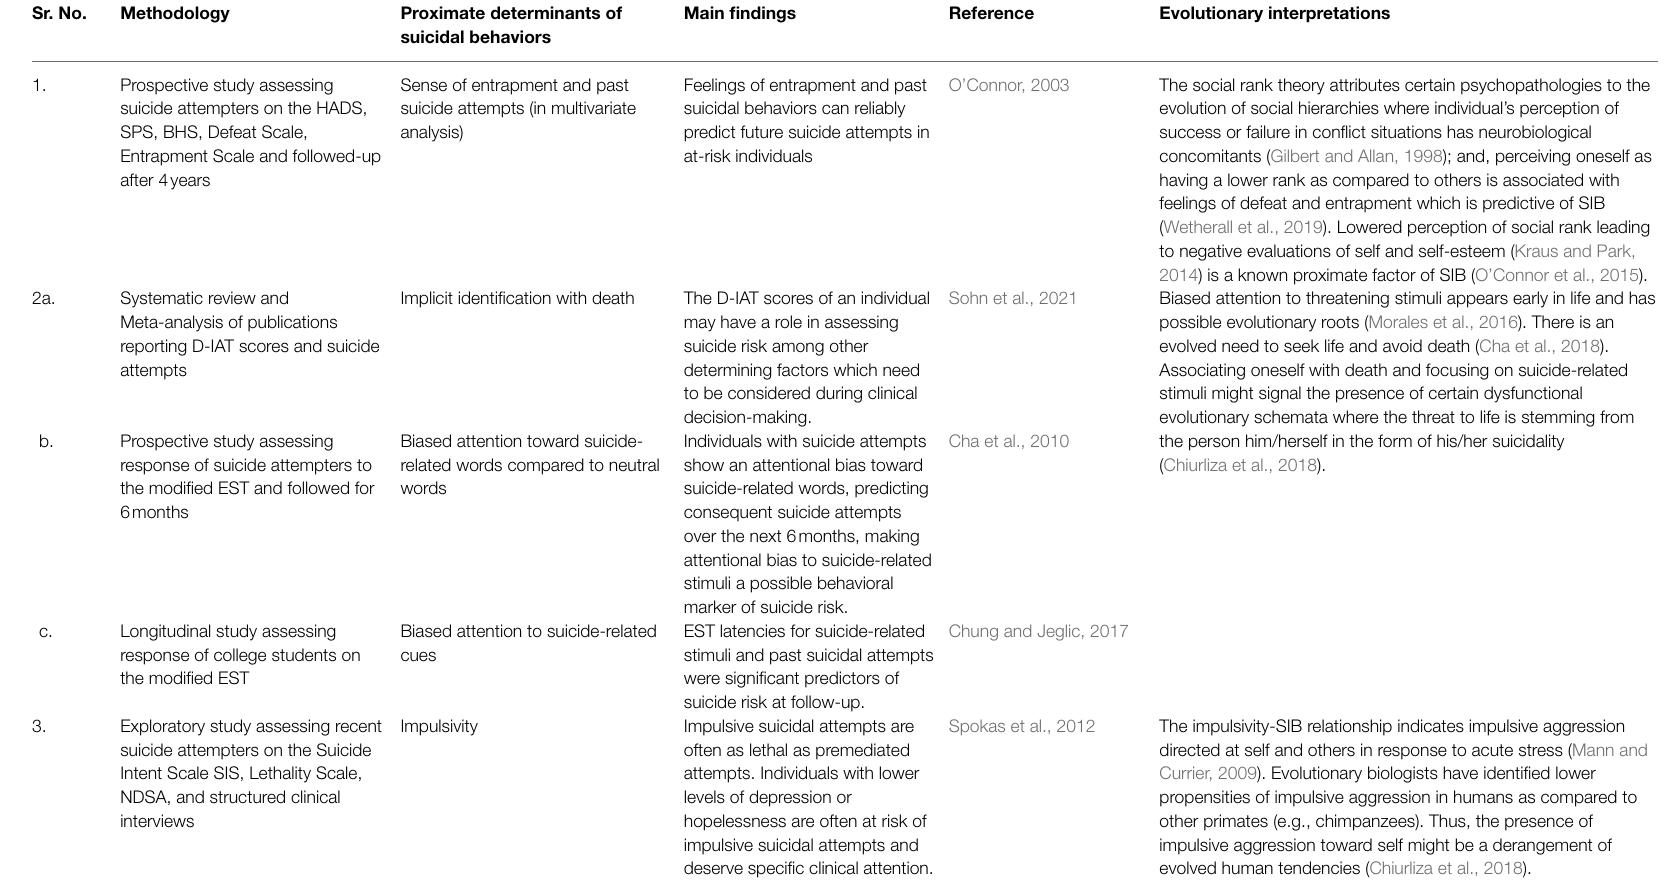
TABLE 1 | Summary of Evolutionary explanations for proximate personal factors predicting suicide. Sr.